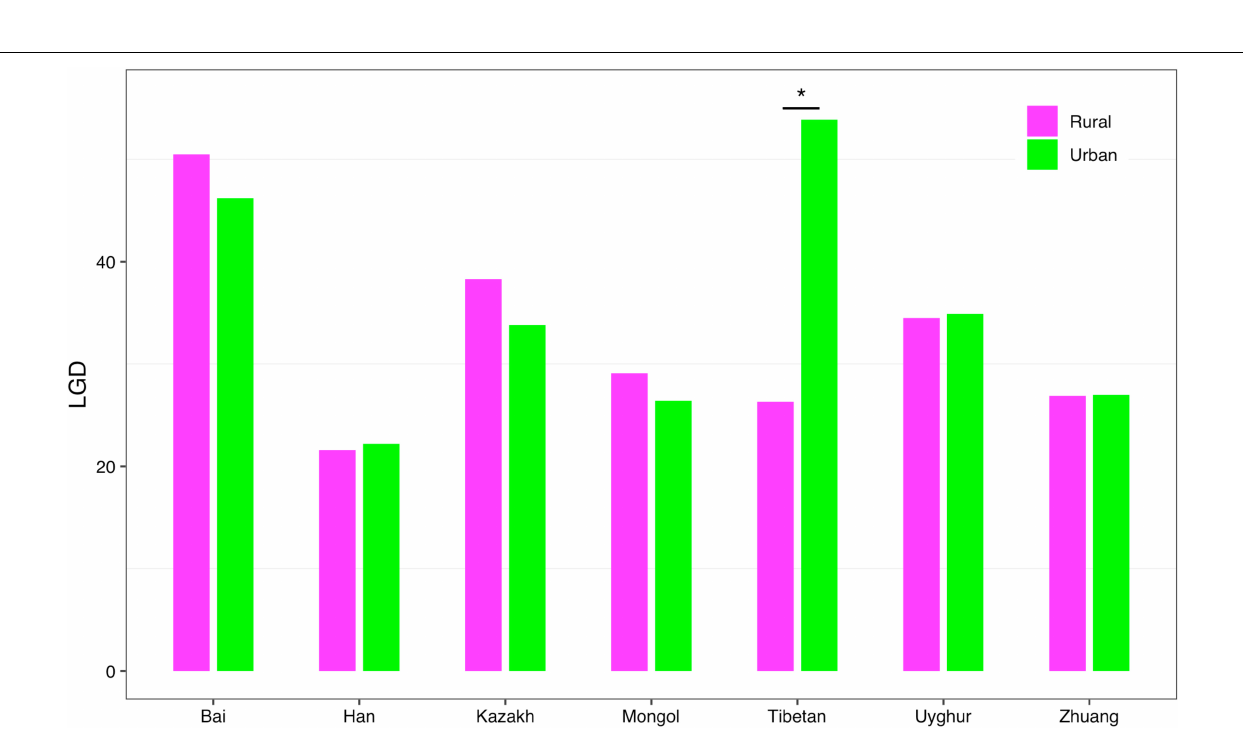
Frontiers in Microbiology |